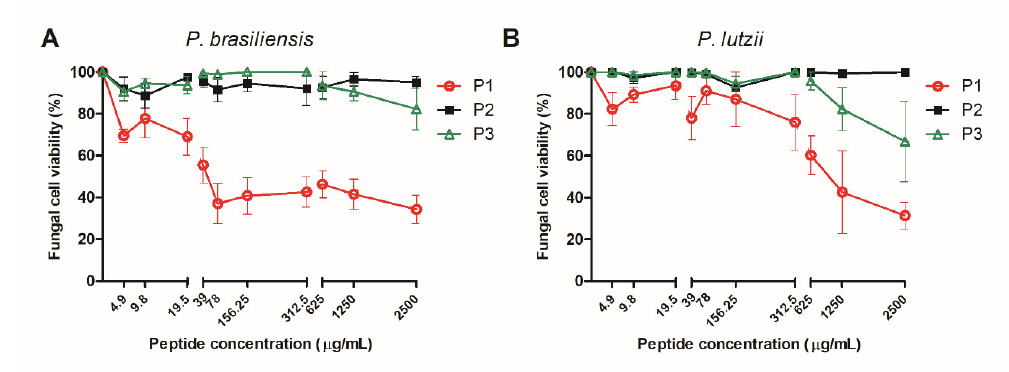
Figure 3. Growth inhibition of 14-3-3 protein peptides (P1, P2, P3) evaluated by microdilution assay against P. brasiliensis ( A ) and P. lutzii ( B ) concentrations ranging from 4.9 to 2500 µg/mL. Data expressed as mean ± standard deviation of two biological replicates and two independent